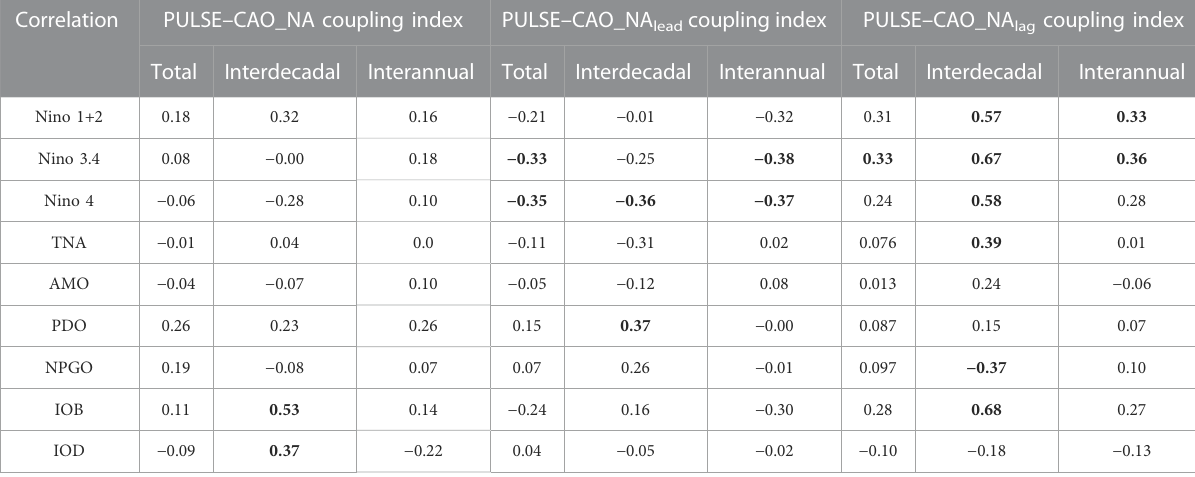
Numbers in bold indicate correlations statistically signi fi cant above the 95% con fi dence